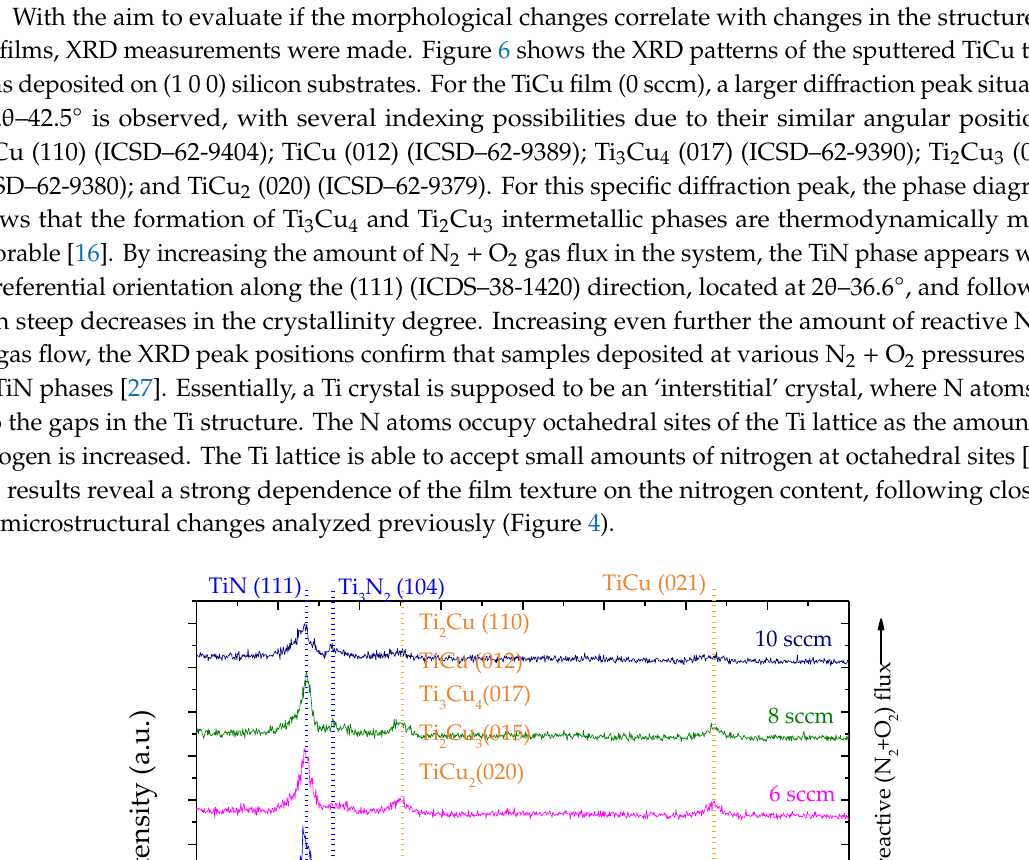
Figure 5. Deposition rate of TiCu(O,N) thin films and target potential as a function of the increasing N 2 + O 2 flux.